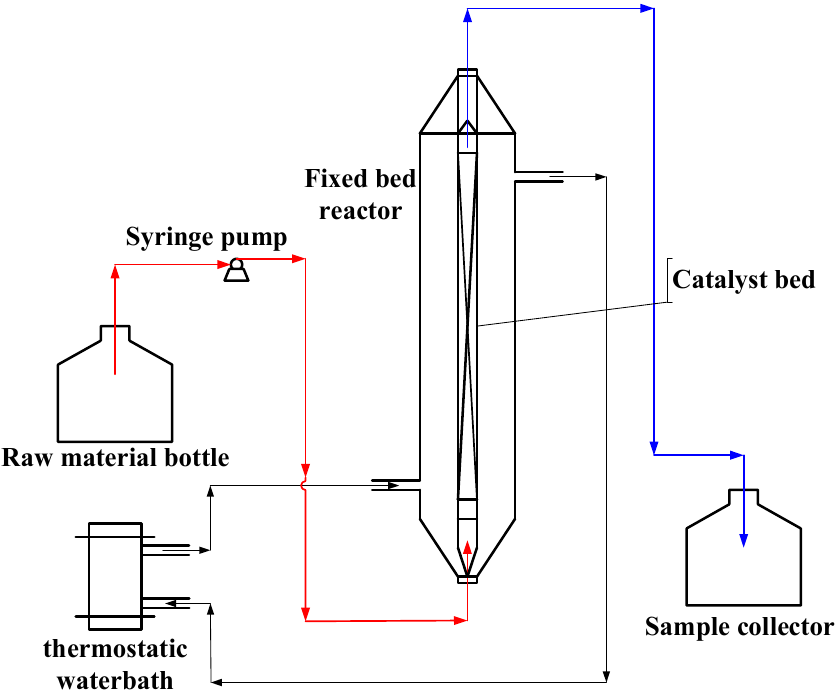
Scheme 6. Schematic diagram of a catalytic unit.